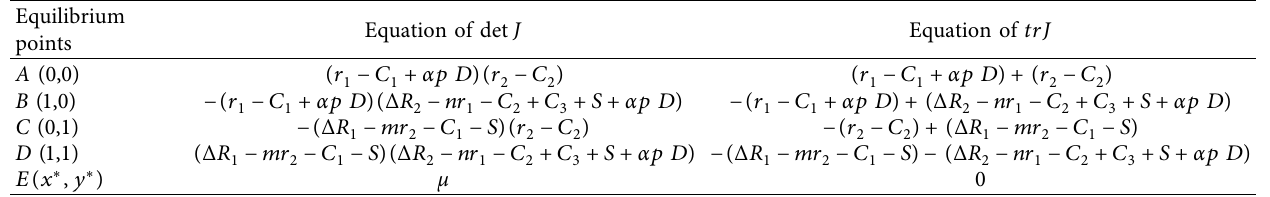
Table 3: The determinant and trace at each equilibrium